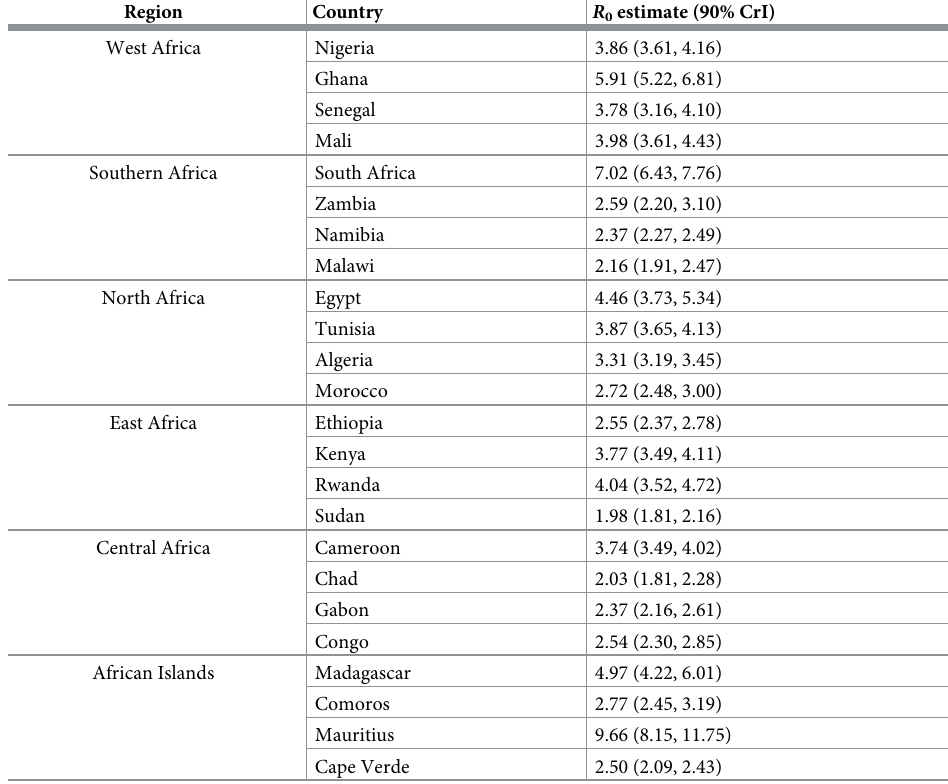
Table 2. Estimated basic reproduction number. The estimated basic reproduction number for each country with 90% credible interval